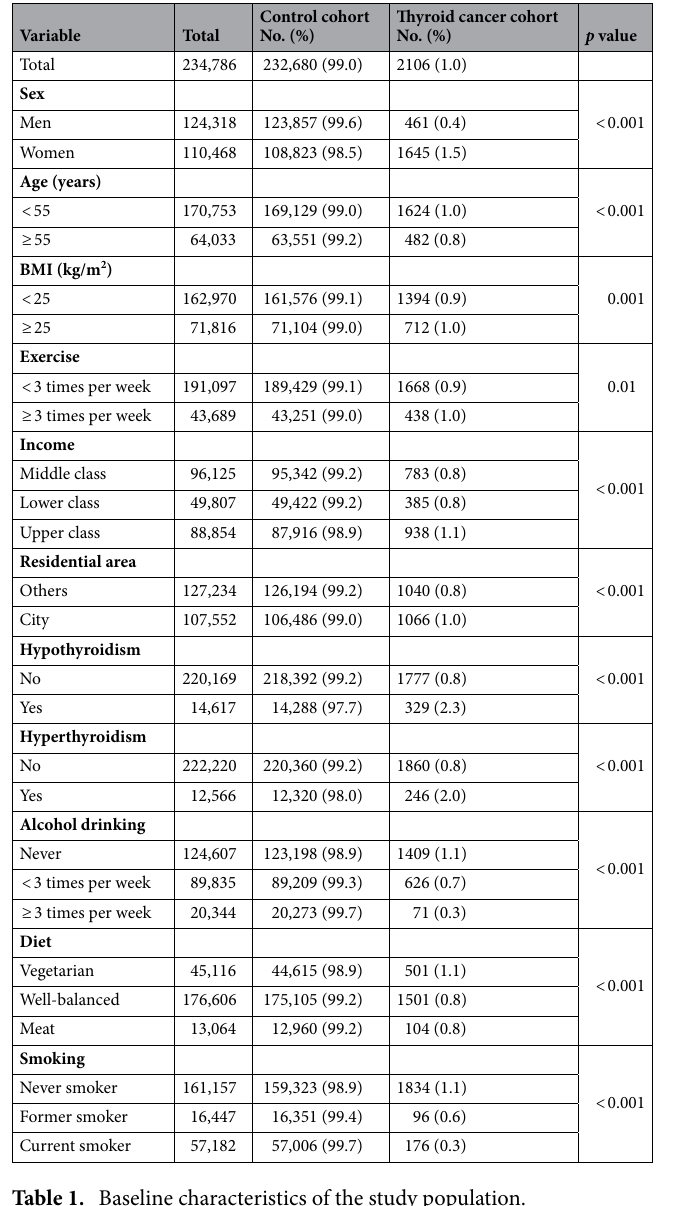
Table 1. Baseline characteristics of the study